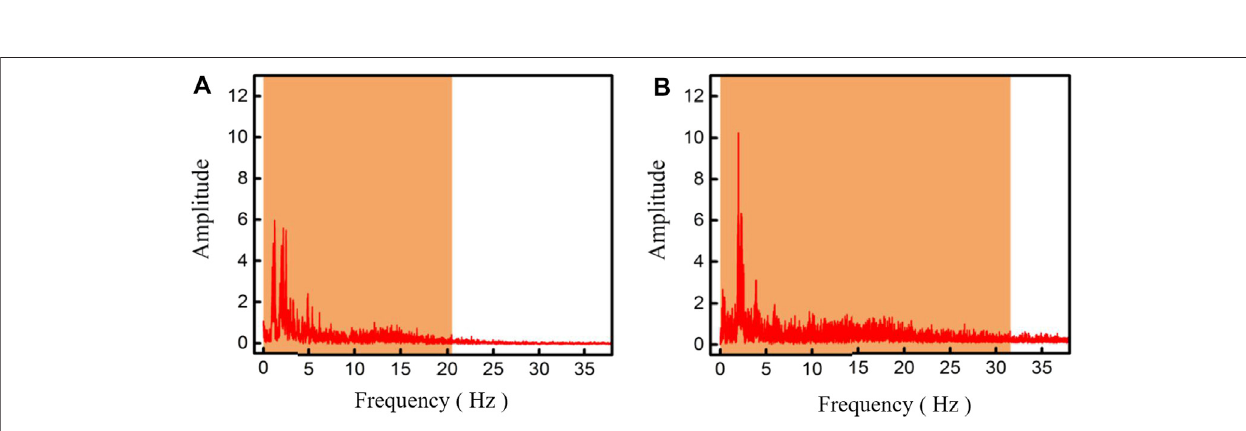
FIGURE 10 | (A) Spectrogram of walking. (B) Spectrogram of